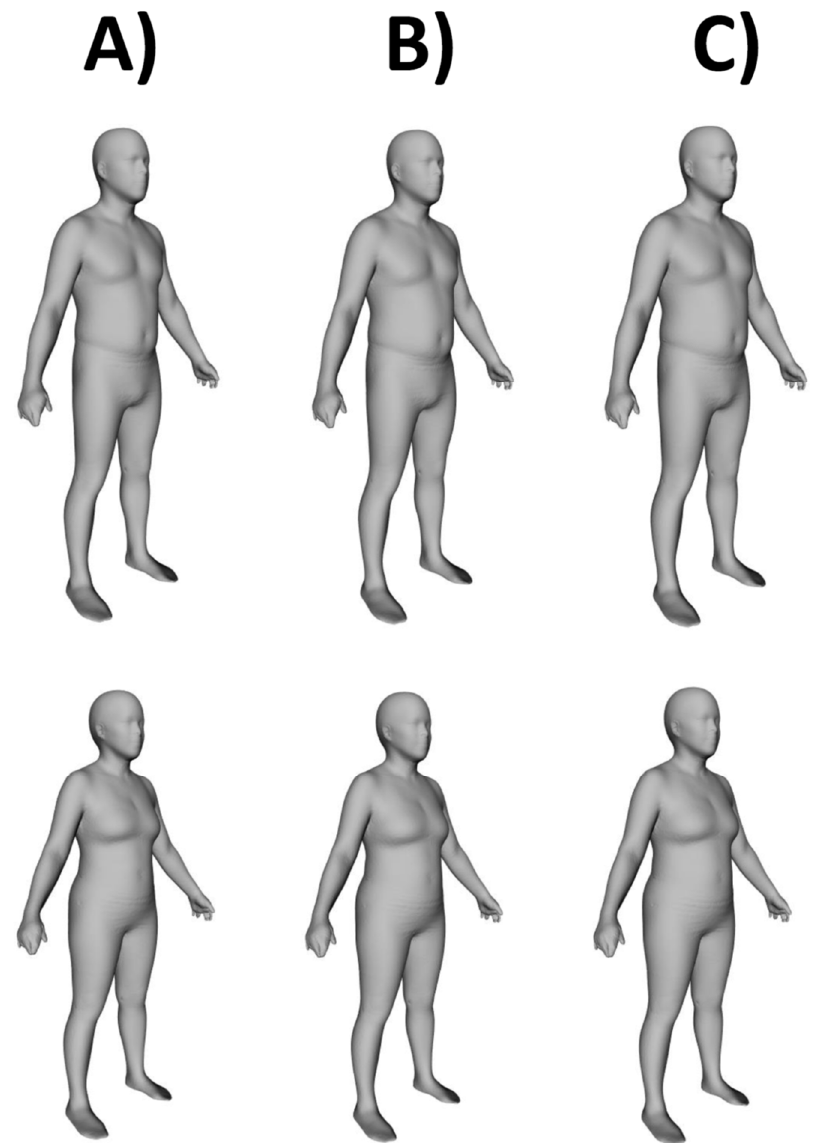
Figure 3. Representative humanoid avatars of average European men ( top row ) and women ( bottom row ) at three time points between 1993 and 2019 as defined by mean population height, weight, and waist circumference. Mean anthropometric data were obtained from the following two cohorts: (i) the Italian cohort of the European Prospective Investigation into Cancer and Nutrition (EPIC-Italy); (ii) Health Survey for England (HSE). Time points: ( A ) Average data from EPIC-Italy